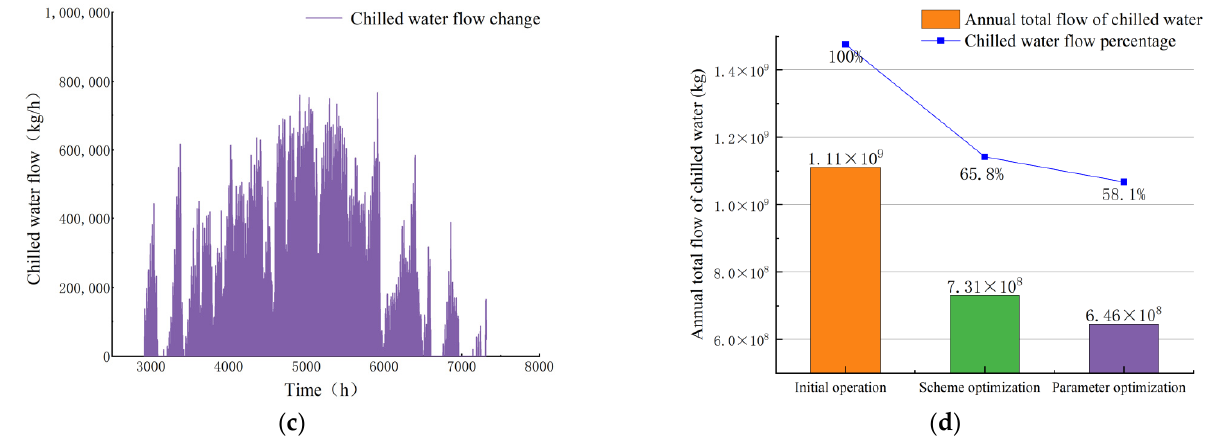
Figure 11. Chilled water flow under different optimized strategies. ( a ) Chilled water flow under initial operation; ( b ) Chilled water flow under scheme optimization; ( c ) Chilled water flow under parameter optimization; ( d ) Comparisons of annual total chilled water under different optimized methods.